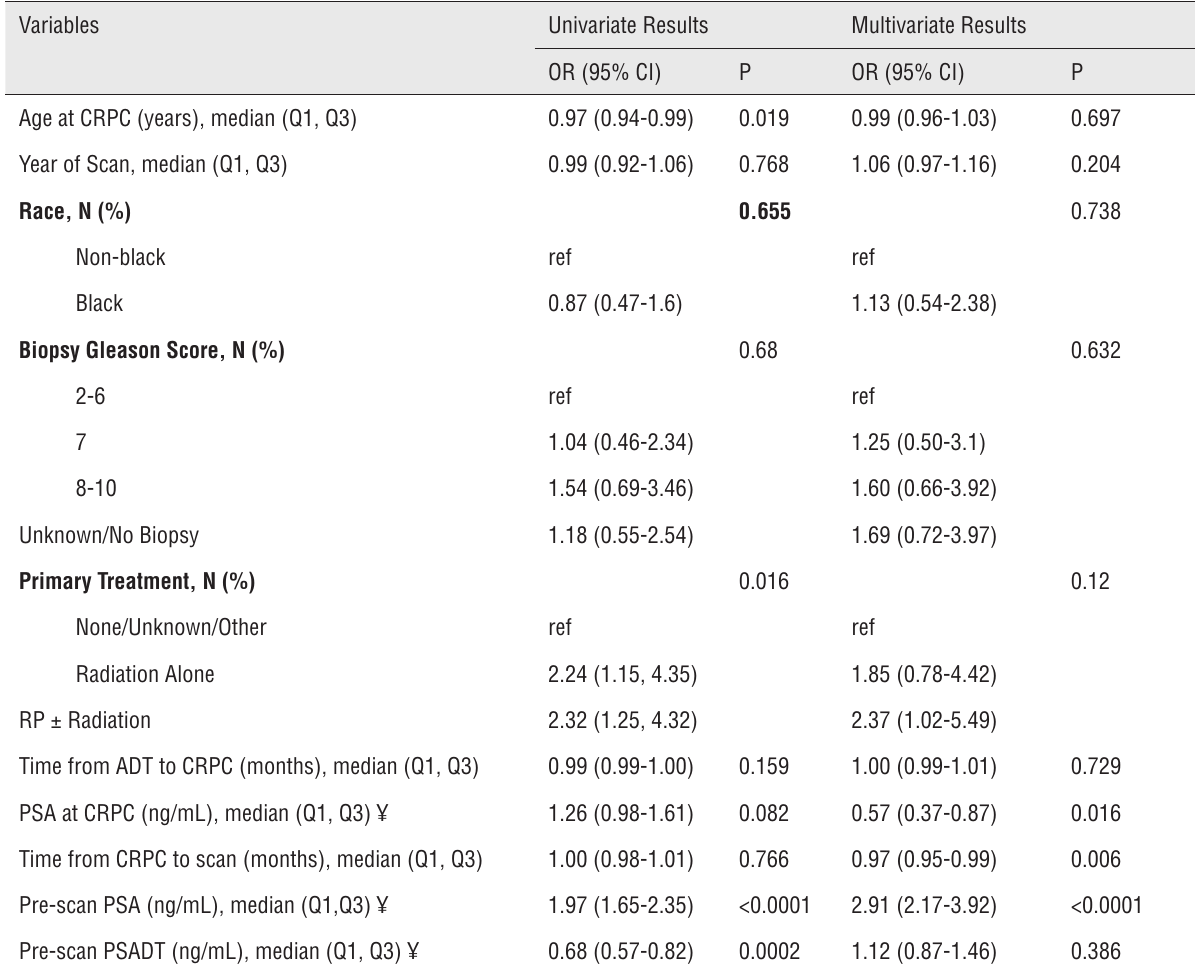
Table 3 - Predictors of Bone Scan